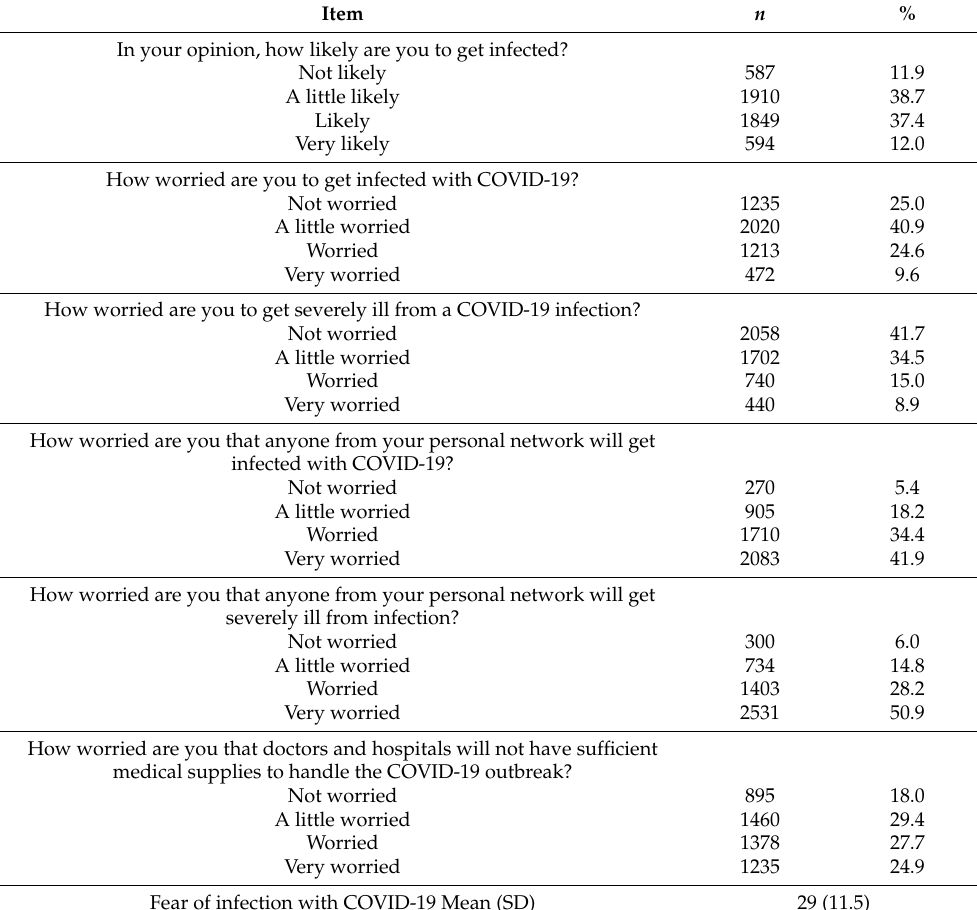
Table 1. Descriptive baseline characteristics of fear of infection.